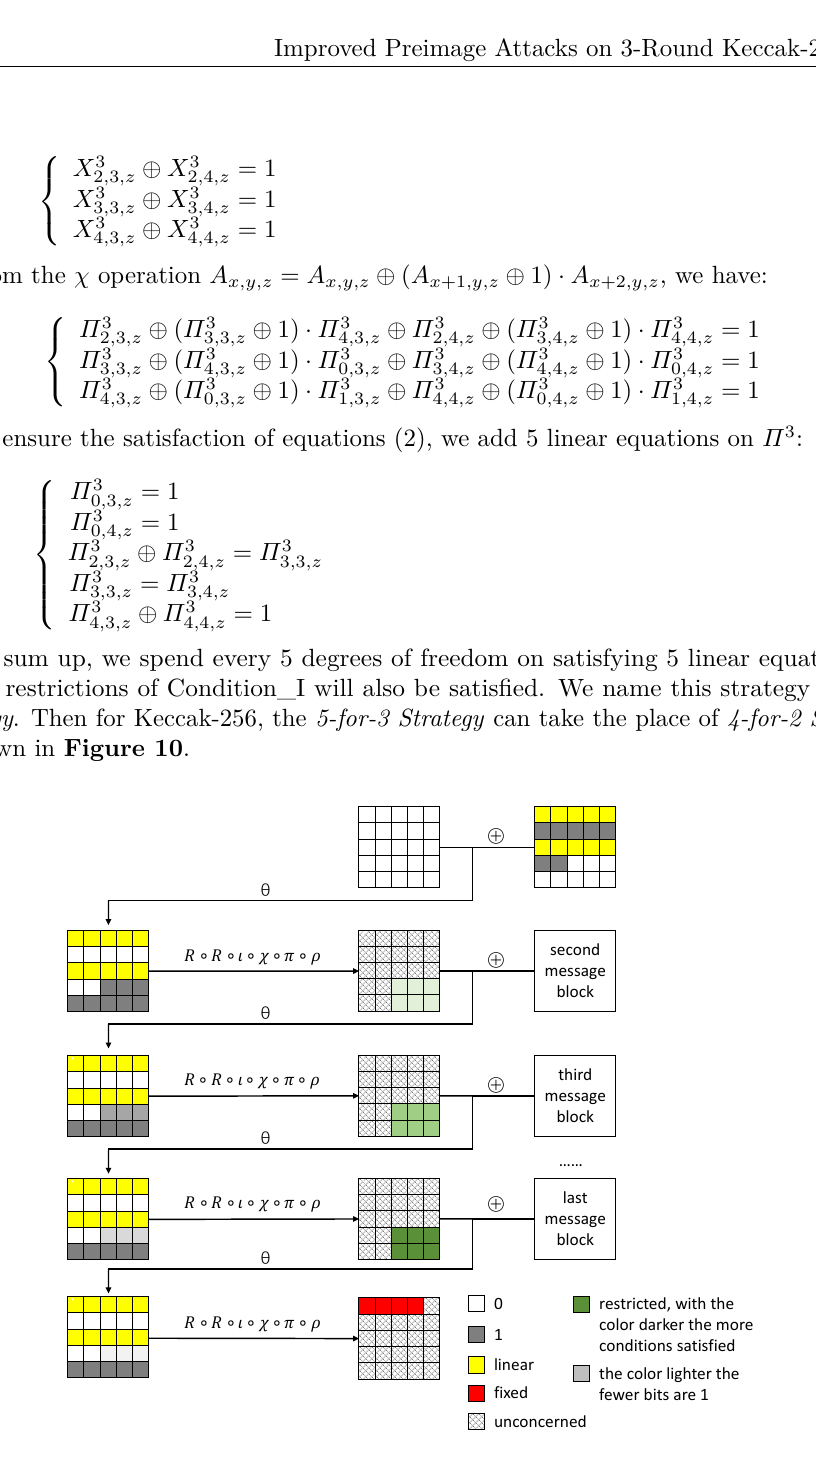
Figure 10: Iterating Strategy via 5-for-3 Strategy on 3-round Keccak-256. ( R = ι ◦ χ ◦ π ◦ ρ ◦ θ ) The overall complexity of improved preimage attacks on 3-round Keccak-256 via Iterating Strategy and 5-for-3 Strategy is analyzed as